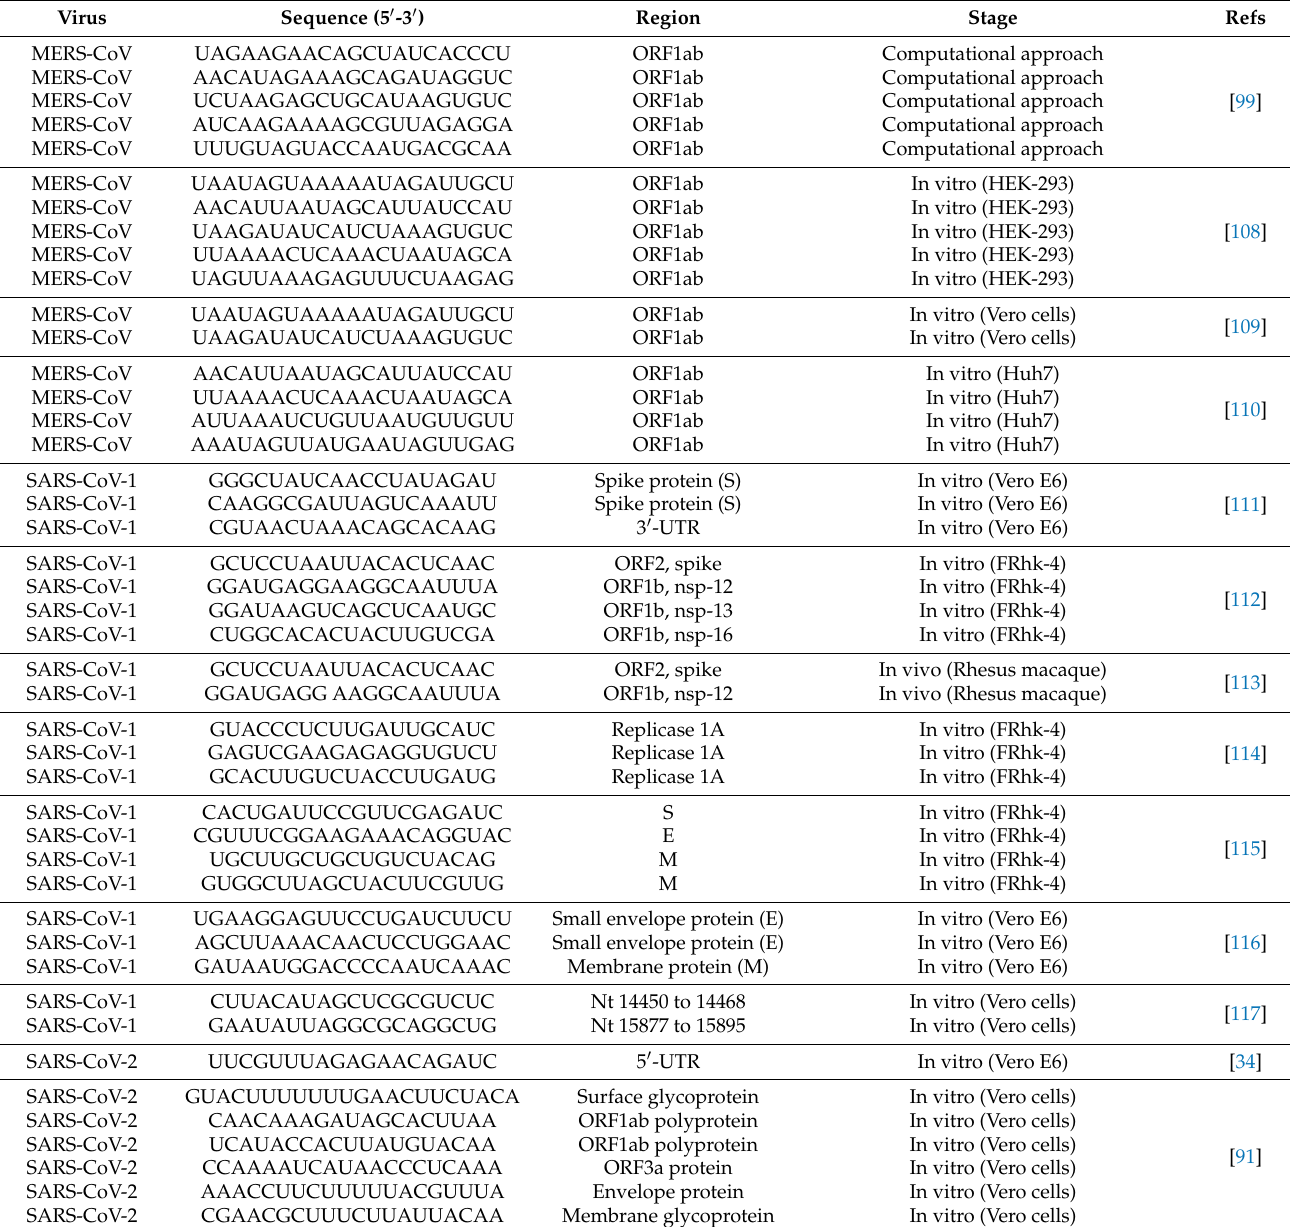
Table 1. siRNA therapeutics for SARS-CoV-2, SARS-CoV-1, and